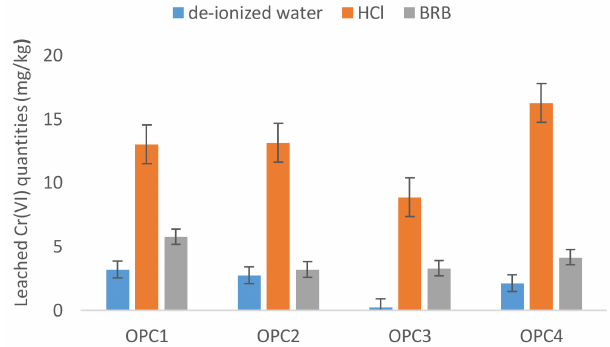
Figure 2. A comparison of the Cr(VI) amounts leached from cements in deionized water, BRB and HCl.